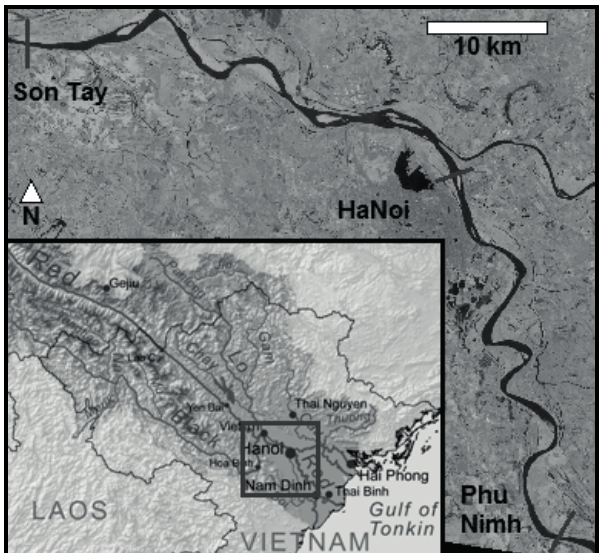
Fig. 1 . Lower course of the Red River in